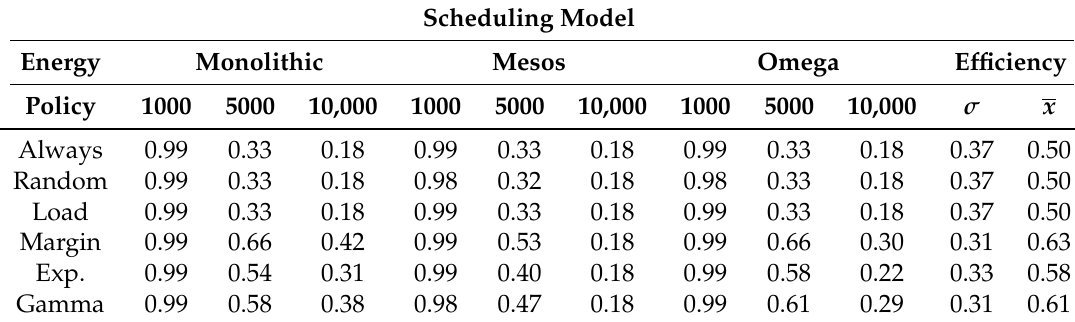
Table 4. Efficiency analysis of energy